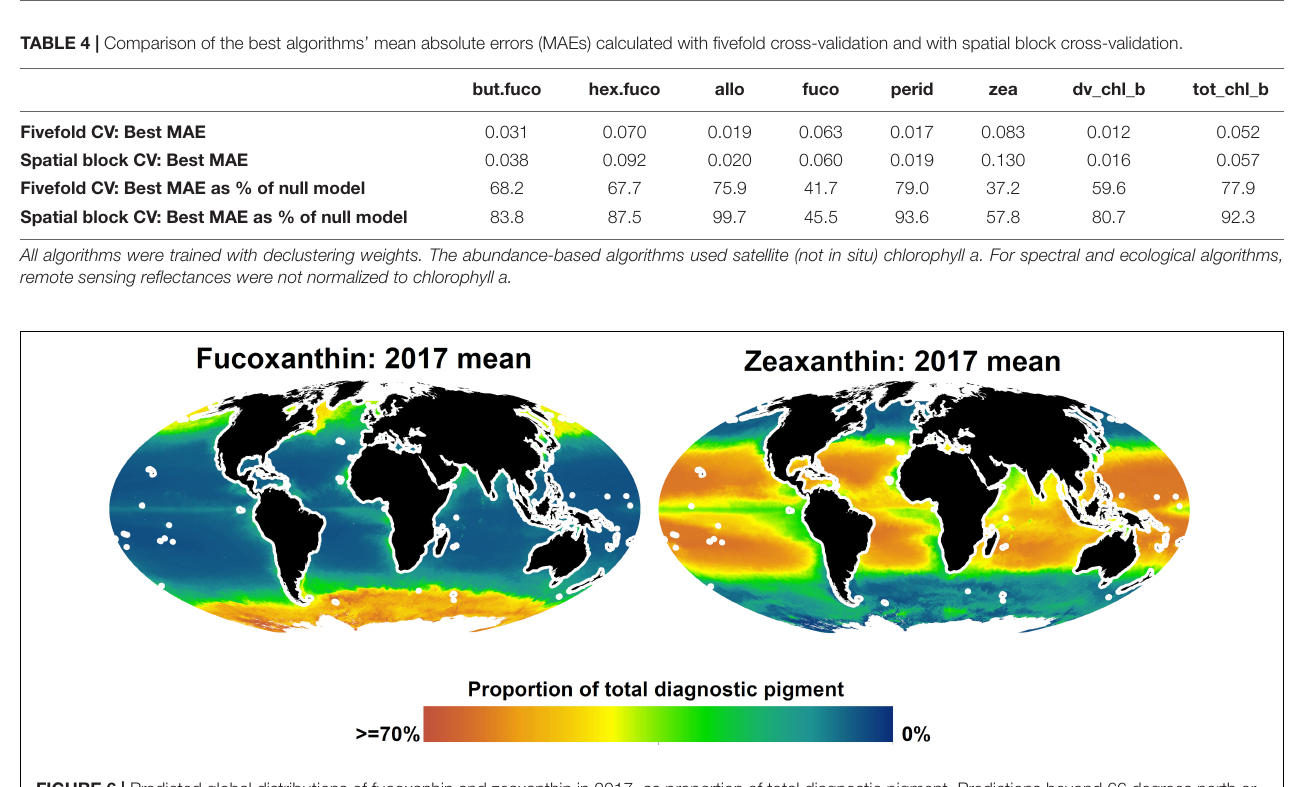
FIGURE 6 | Predicted global distributions of fucoxanhin and zeaxanthin in 2017, as proportion of total diagnostic pigment. Predictions beyond 66 degrees north or within 200 km of land are not